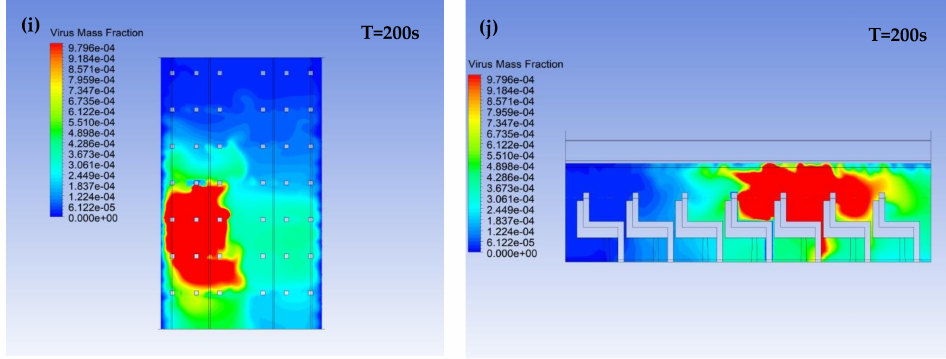
Figure 3. The dynamic 5 s, 50 s, 100 s, 150 s, 200 s after the virus carrier’s single cough (left: ( a , c , e , g , i )-Plane 1; right: ( b , d , f , h , j )-Plane 2).